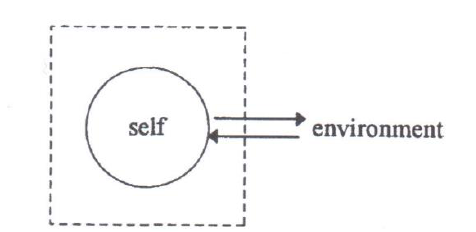
Figure 26: Healthy Core-Self Relational Position (Evans 1998 p. 293)